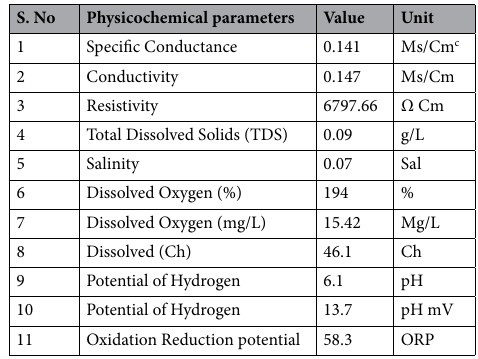
Table 2. Physicochemical parameters observed from the freshwater sample collected from Chembarambakkam lake on 3rd January